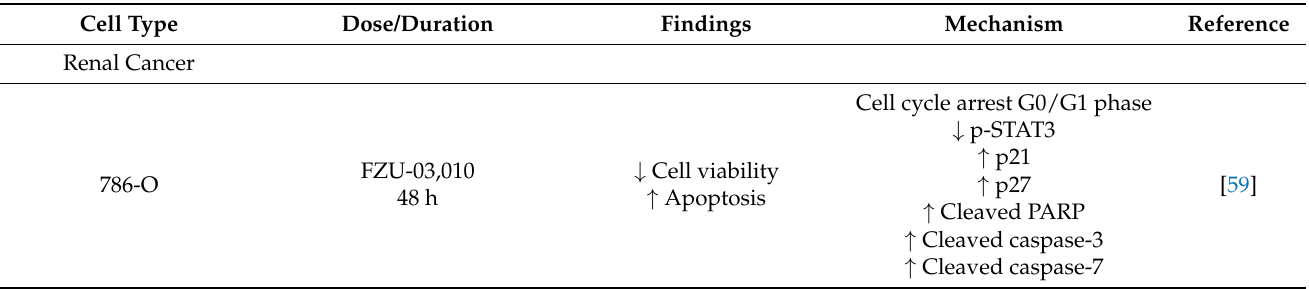
Table 4. Effects of ursolic acid derivatives against renal and bladder cancers: summary of existing